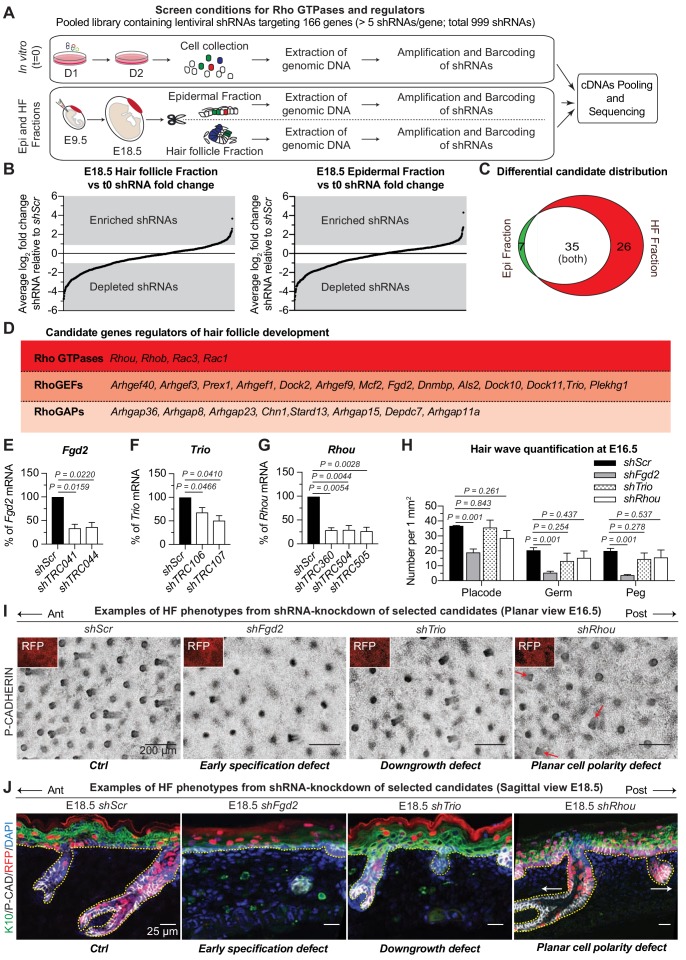
RNAi screen hits reveal Rho GTPase regulators of hair follicle morphogenesis.(A) Schematic representation of our in vivo screen for Rho GTPases and their regulators. (B) In vivo screen results showing the absolute log2 fold change for each individual shRNA present in the HF (left) and epidermal (right) fractions relative to their initial representation and normalized to 20 Scr-shRNA controls. (C) Venn diagram showing distribution of gene candidates among the epidermal and HF fractions. Candidates preferentially enriched or depleted in the epidermal fraction are highlighted in green and candidates preferentially affected in the HF fraction are highlighted in red. (D) Functional classification of the 26 candidates that were specifically either enriched or depleted in the HF fraction. (E–G) qPCR analyses in mouse keratinocytes validate shRNA-mediated knockdown of selected screen candidates. Error bars represent SEM from n = 3 experiments. Normal distribution of the data was tested using the Shapiro-Wilk test. Parametric paired two-tailed independent t-test was used to compare the data, (H) Quantifications of the numbers of placodes, germs and pegs from the different staggered HF waves in shScr, shFgd2, shTrio and shRhou -transduced E16.5 head skin. Error bars represent SEM from shScr n = 3, shFgd2 n = 3, shTrio n = 3 and shRhou n = 5 embryos. Normal distribution of the data was tested using the Shapiro-Wilk test. Parametric independent two-tailed unpaired t-test was used to compare the data.(I) Examples of HF phenotypes from shRNA-knockdown of selected candidates. Z-projections of planar views from whole-mount immunofluorescence of transduced E16.5 head skins. RFP (insets) verifies transduction. Representation of n = 3 embryos for each condition. Scale bars, 200 μm. (J) Examples of HF phenotypes. Immunofluorescence of sagittal sections from transduced E18.5 skins. Representation of n = 3 embryos for each condition. Scale bars, 25 μm.10.7554/eLife.50226.007Figure 2—source data 1.Source data related to Figure 2E,F,G and H.